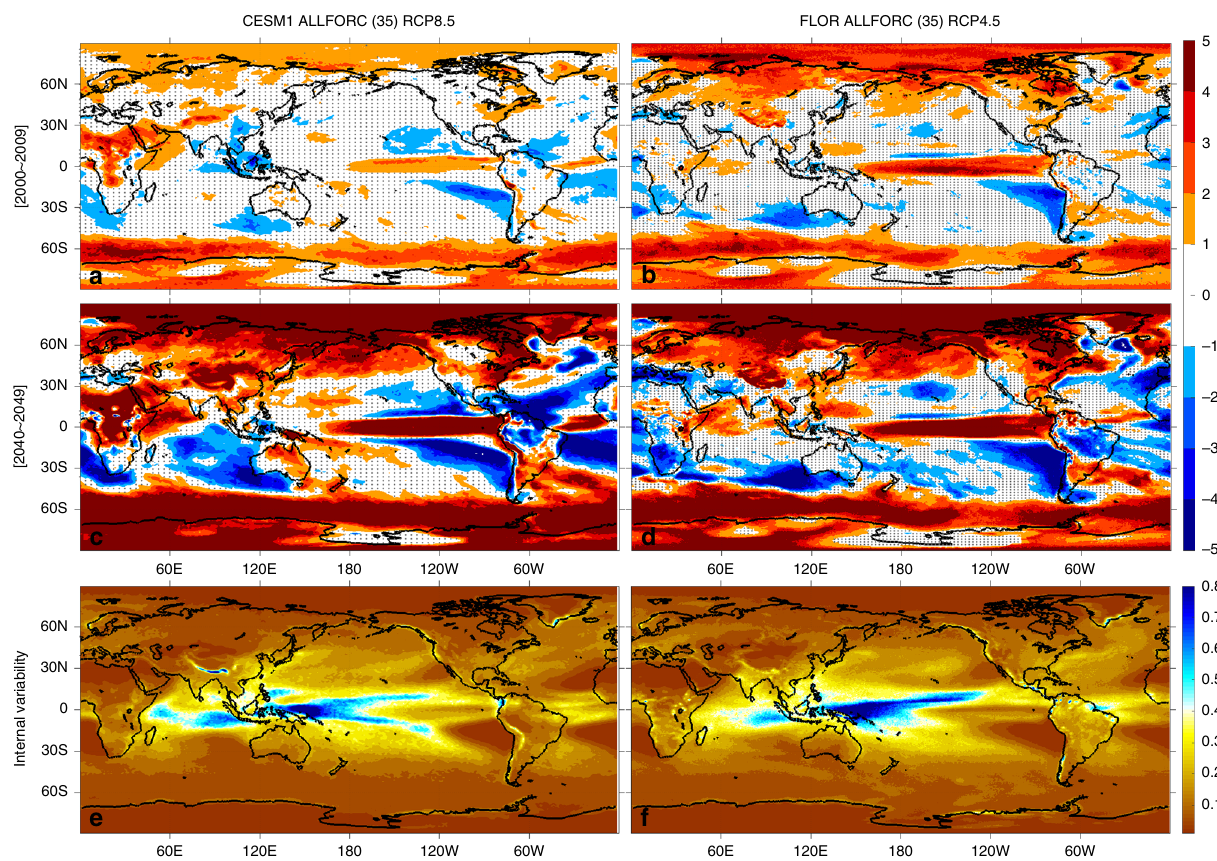
Fig. 3 Signal-to-noise ratio and range of the noise for annual precipitation. a – d signal-to-noise ratio and e, f : range of the noise (mm day − 1 ) for CESM1 ( a, c, e ) and FLOR ( b, d, f ), respectively. The signal is the ensemble-mean precipitation change shown in Fig. 1a – d and the noise is the annual precipitation low-frequency internal variability against which the signal is tested. The range of the noise is estimated as the difference between the maximum and minimum (i.e., the most positive and negative) values of the 5000 samples constructed with the Monte Carlo approach from fully coupled control simulations, where each sample represents the synthetic ensemble-mean precipitation change arising entirely from internal climate variability (see Methods for more details). The signal-to-noise ratio is computed as the ratio of positive (negative) ensemble-mean precipitation change to the maximum (minimum) value of the 5000 samples, which follows the de fi nition of distinguishability (see Methods). Regions without distinguishability (i.e., signal-to- noise ratio between 1 and -1) are indicated by white color with gray stippling in (a-d) (showing the decades of 2000 – 2009 and 2040 – 2049, respectively)